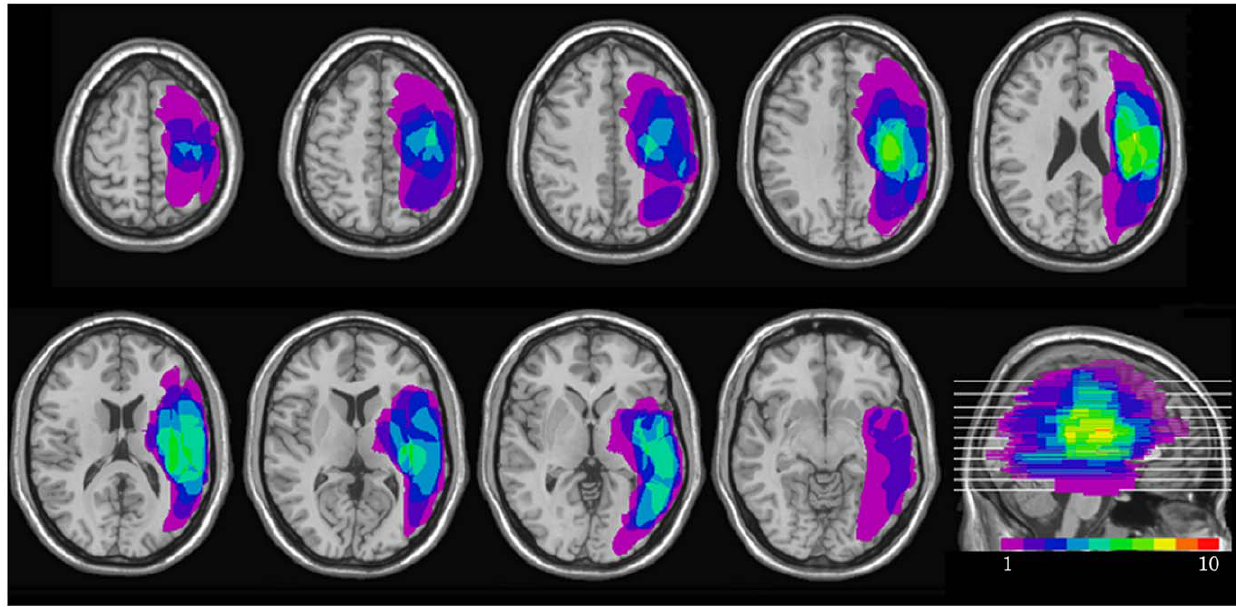
Figure 1. Lesion overlap after summation for all neglect patients (n=10).